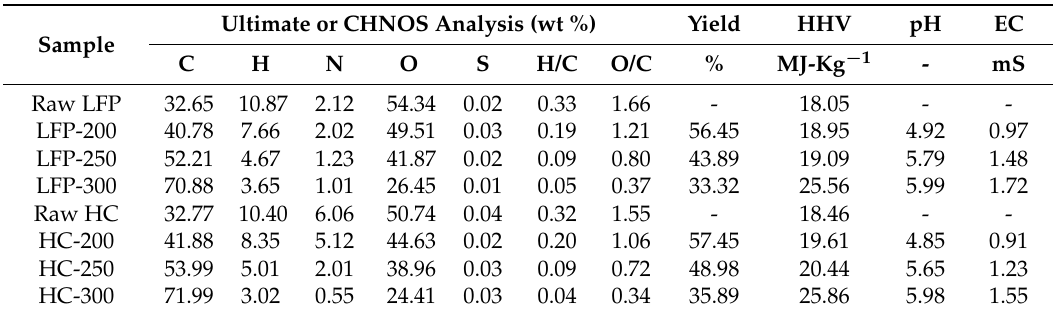
Table 1. Properties of Dimocarpus longan fruit peel powder (LFP) and Holocellulose (HC) with their carbonized samples at different